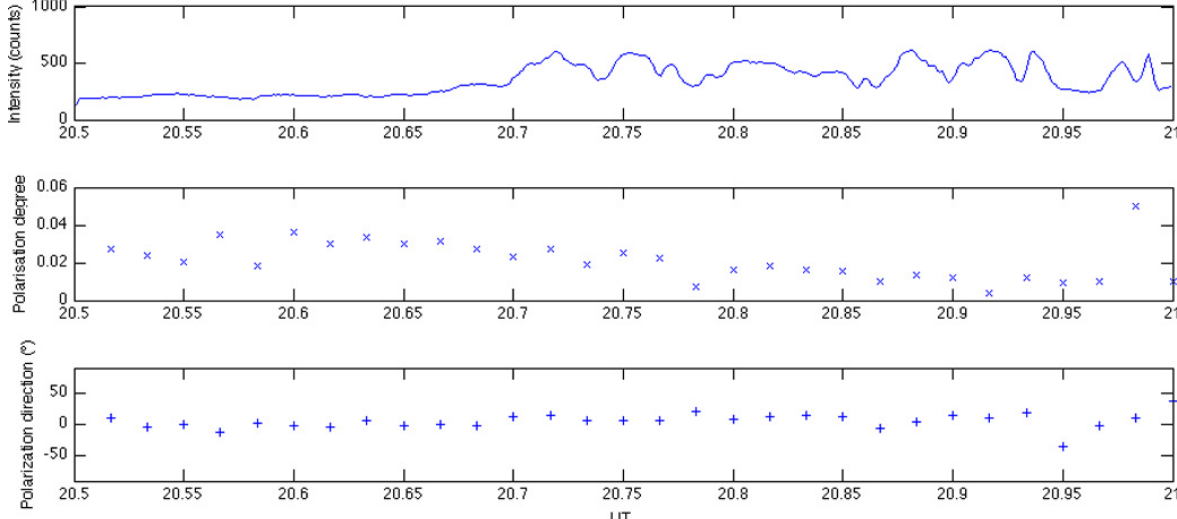
Fig. 5. Northward optical observations versus time (11 December 2007). UT is in decimal hour. Top panel: Intensity in counts; mid panel: polarisation degree; bottom panel: polarisation direction in degree from the vertical following the trigonometric direction.